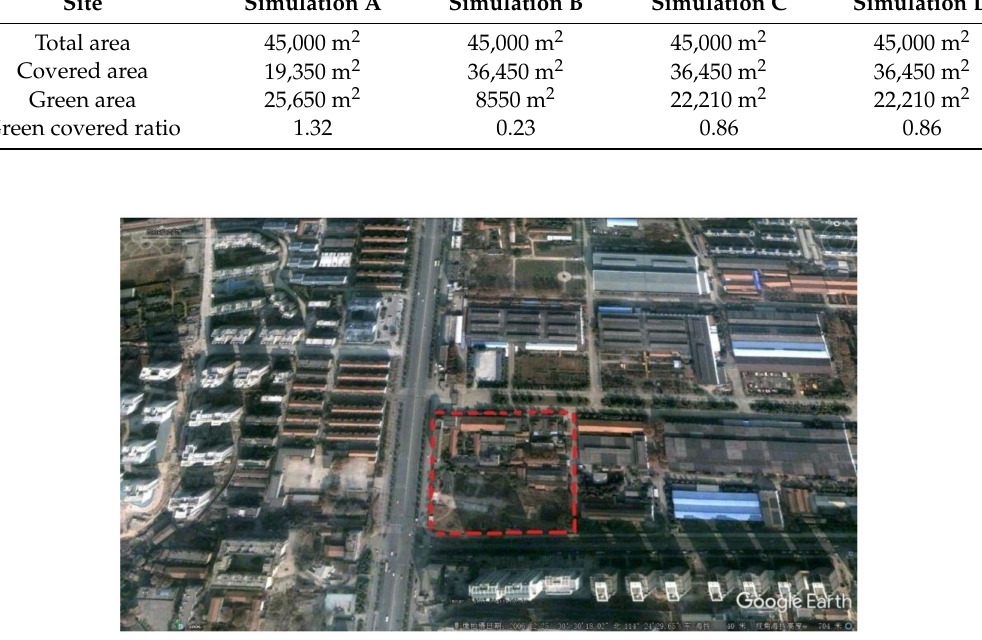
Figure 3. 2006 site